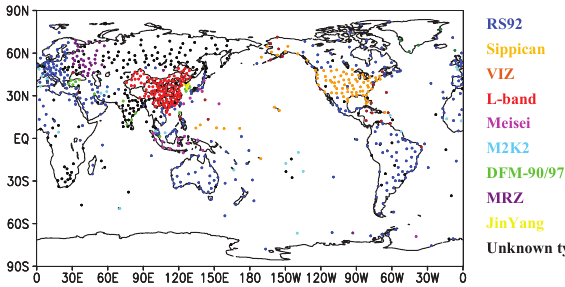
Figure 8. Geographical distribution of operational radiosonde sen- sor usage.